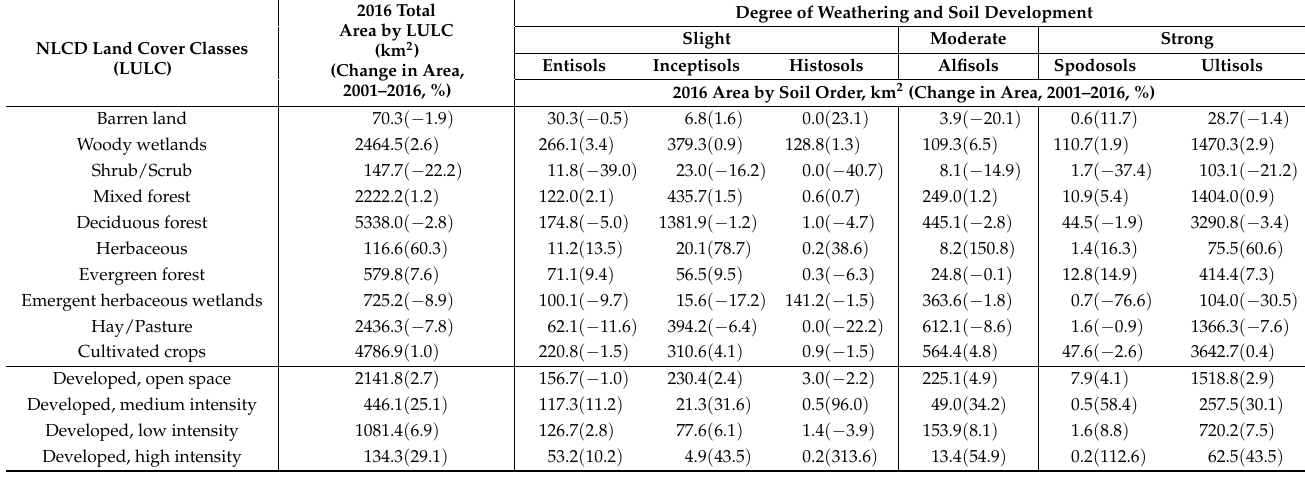
Table 6. Land use/land cover (LULC) change by soil order in Maryland (USA) from 2001 to 2016.